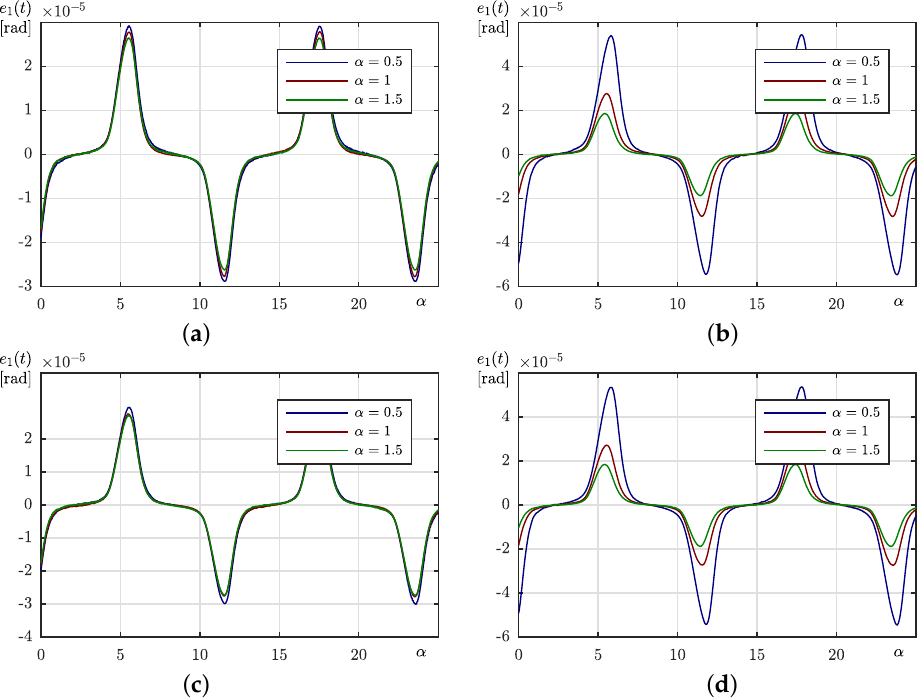
Figure 5. A comparison of the steady-state tracking error for slow trajectory: ( a ) CO, ( b ) CFO, ( c ) EO, ( d ) EFO.